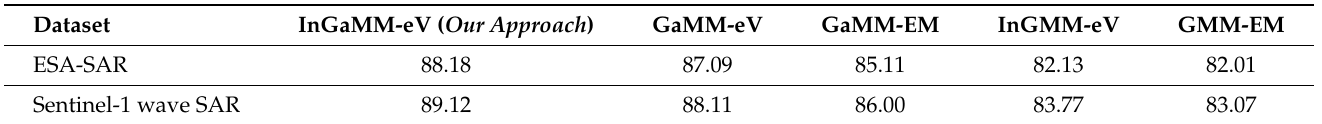
Table 4. Overall oil spill detection rate of different models for 2 datasets using the second feature extraction approach (Dark spots, geometrical, physical, and characteristics features).